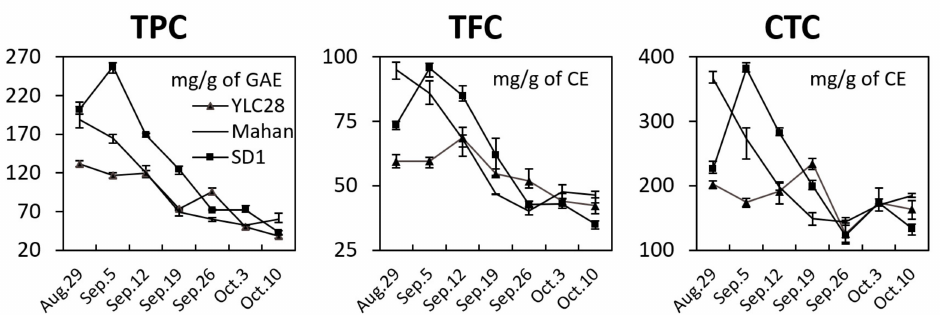
Figure 1. The dynamic changes of phenolic components content during pecan kernel development in three genotypes. Total phenolic content (TPC), total flavonoid content (TFC), and condensed tannin content (CTC). The experiments were repeated three times and the data are presented as the mean ± standard error (SE).